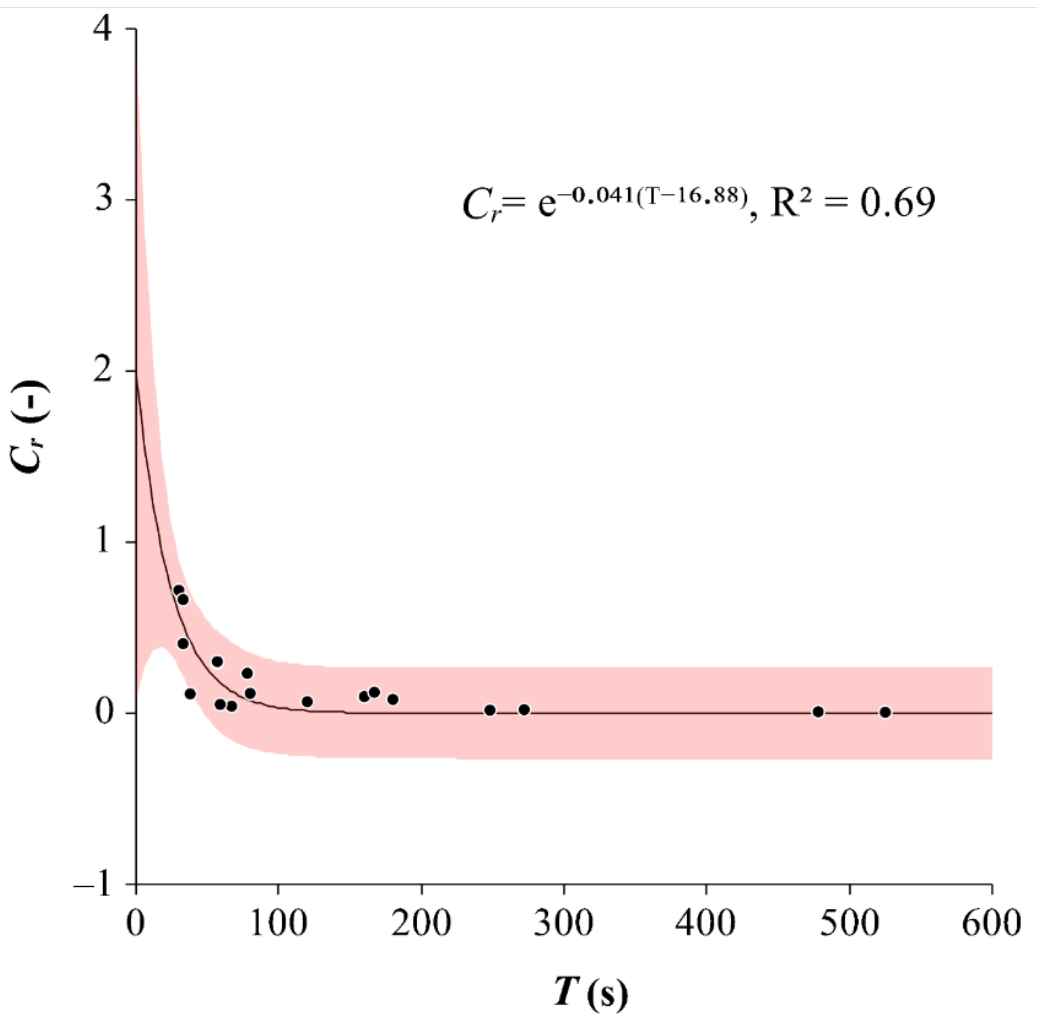
Figure 4. The relationships of surface runoff coefficient, C r , vs. time to runoff, T , in sandy soil at experimental sites S2 and S3 at Studienka village in the Borsk á n í žina lowland (southwestern Slovakia). (Black line—regression curve, red area—the upper and lower boundaries of a prediction interval at a specific value of T , black dots—measured values).